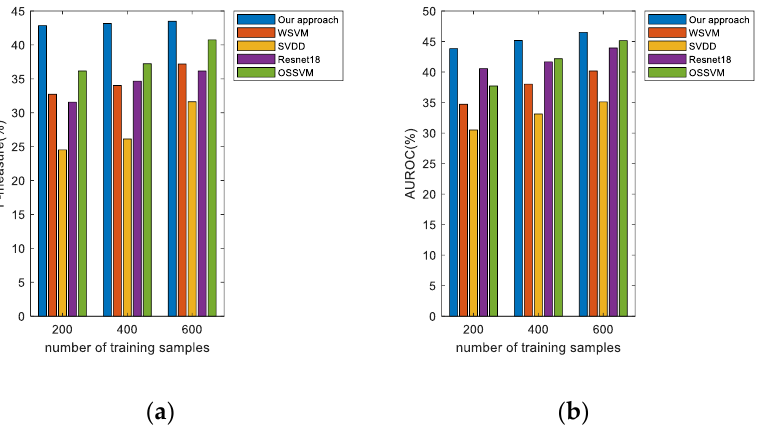
Figure 10. AUROC and F1-measure, when openness is about 0.6, for open-set multi-class recogni- tion using different numbers of training samples on CIFAR100 open dataset: ( a ) F1-measure and ( b ) AUROC.